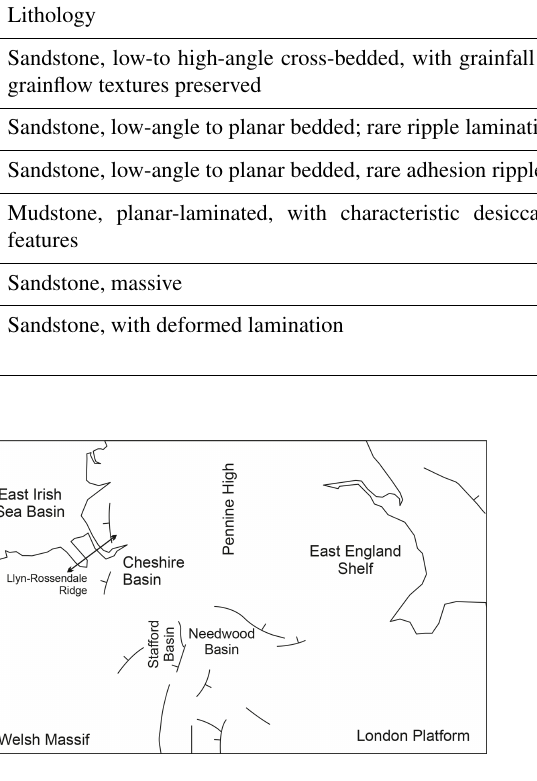
Figure 3. Basin structure of the study area. © UKRI 2019, British Geological Survey, contains Ordnance Survey data © Crown Copy- right and database rights 2019 [licence number 100021290 EUL].